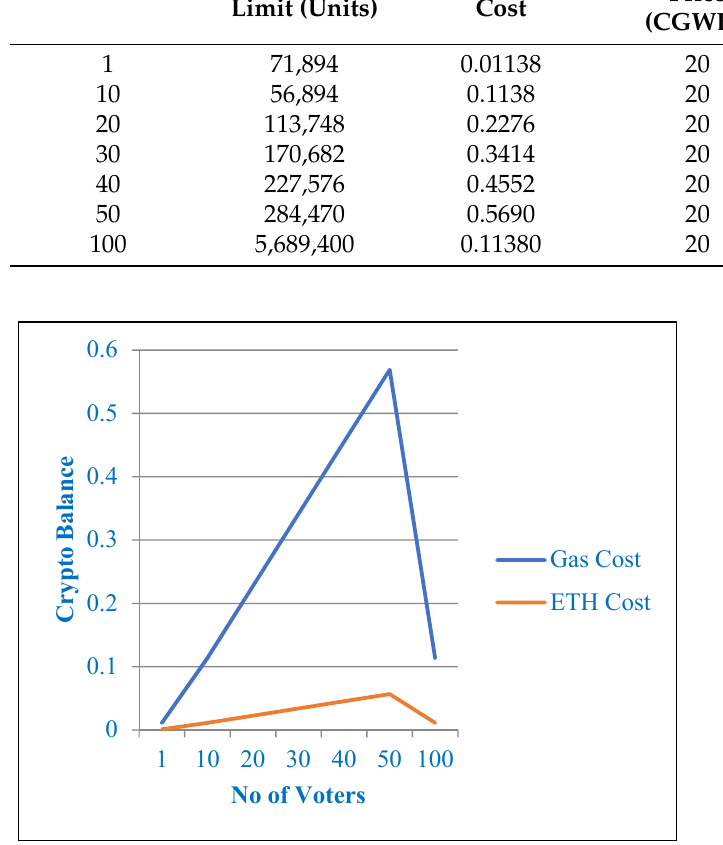
Figure 3. Eth consumption for votes.